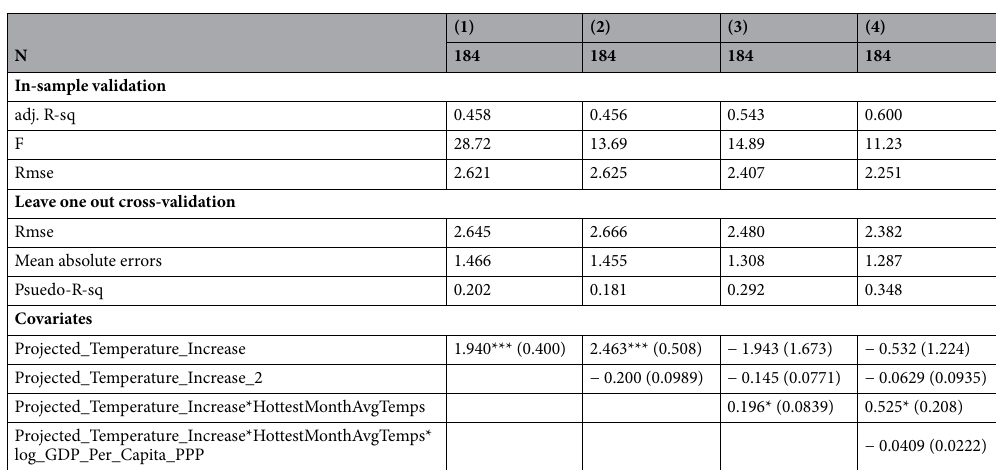
Table 1. Heat model validation. Heat model specification (4) performed the best out of the models both on in-sample validation and out of sample validation. Standard errors in parentheses * p < 0.05, ** p < 0.01, *** p <